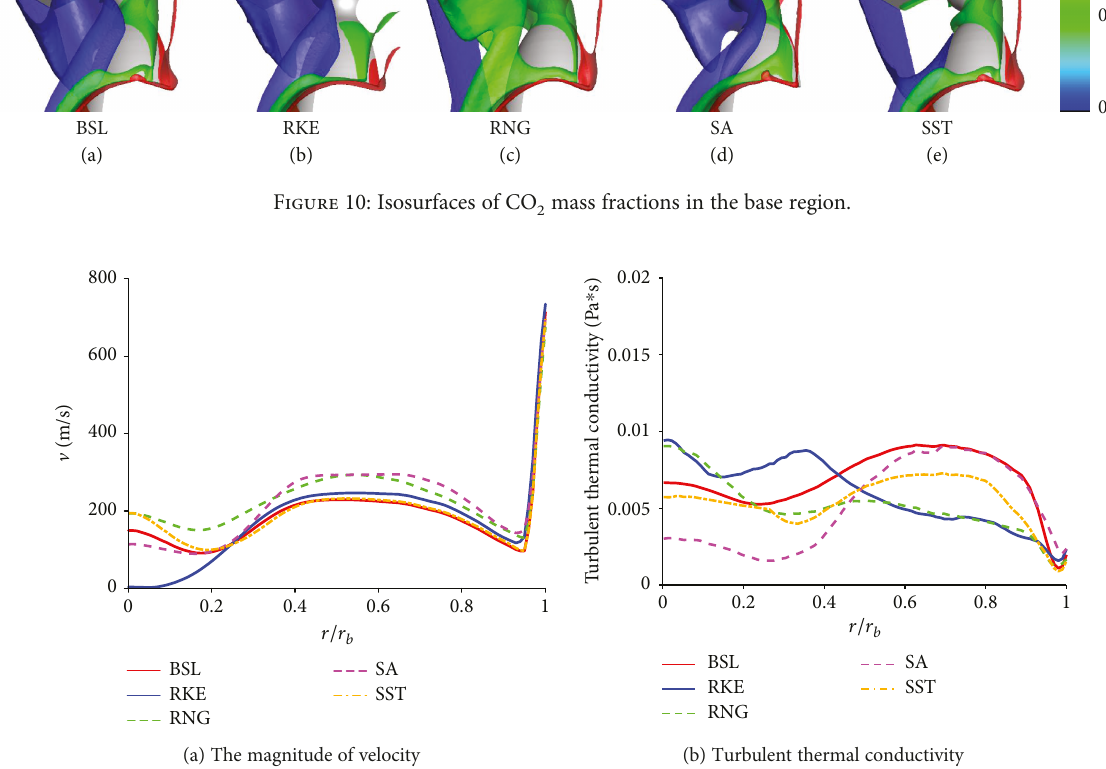
Figure 11: Parameter distributions in the wall jet.